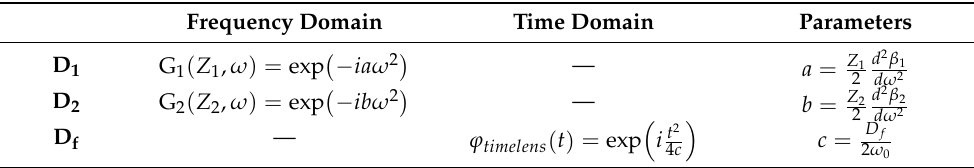
Table A1. Transmission function of the